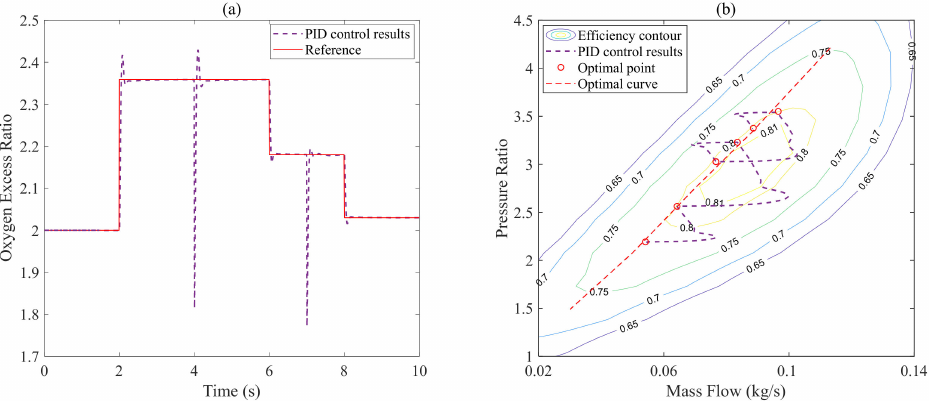
Figure 6. PID algorithm simulation results: ( a ) Oxygen excess ratio following curve; ( b ) Compressor mass flow and pressure ratio